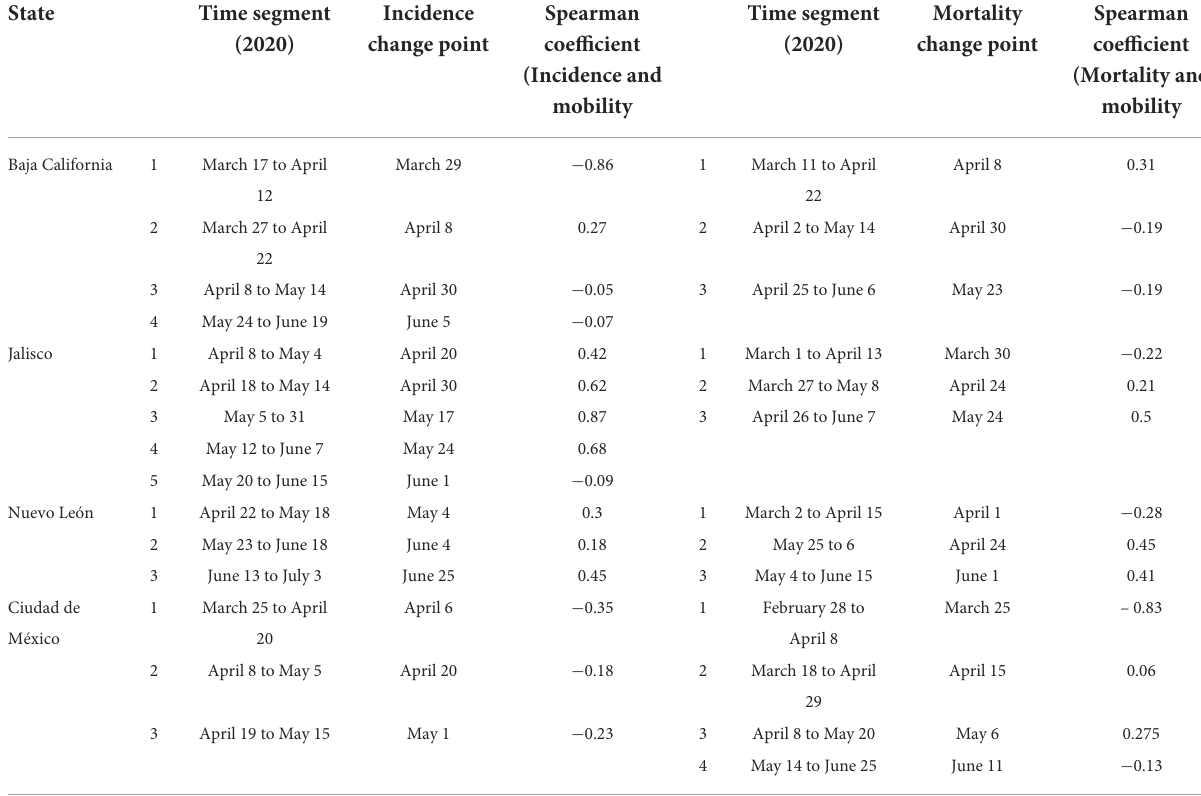
TABLE 2 Spearman’s rank correlation coefficients for mobility and incidence and mortality rates by time intervals from analyzed states in